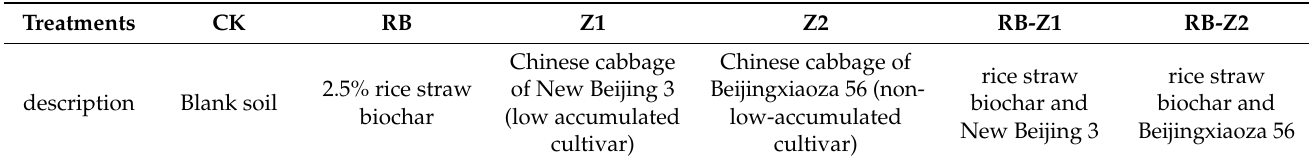
Table 2. The description of different